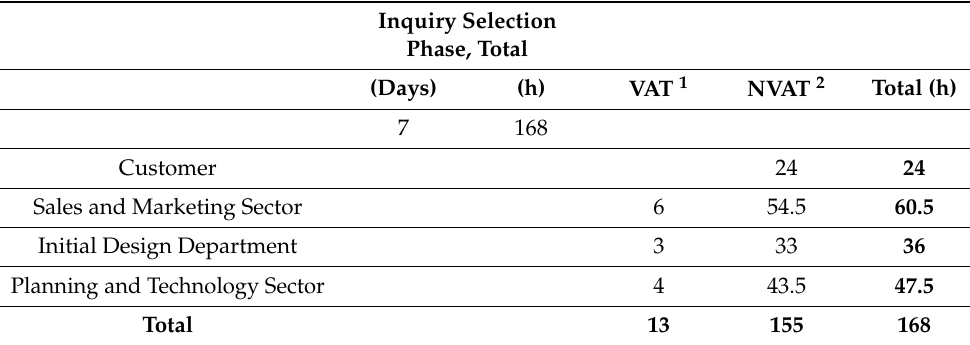
Table A6. The average durations of the inquiry selection phase activities—the future state.